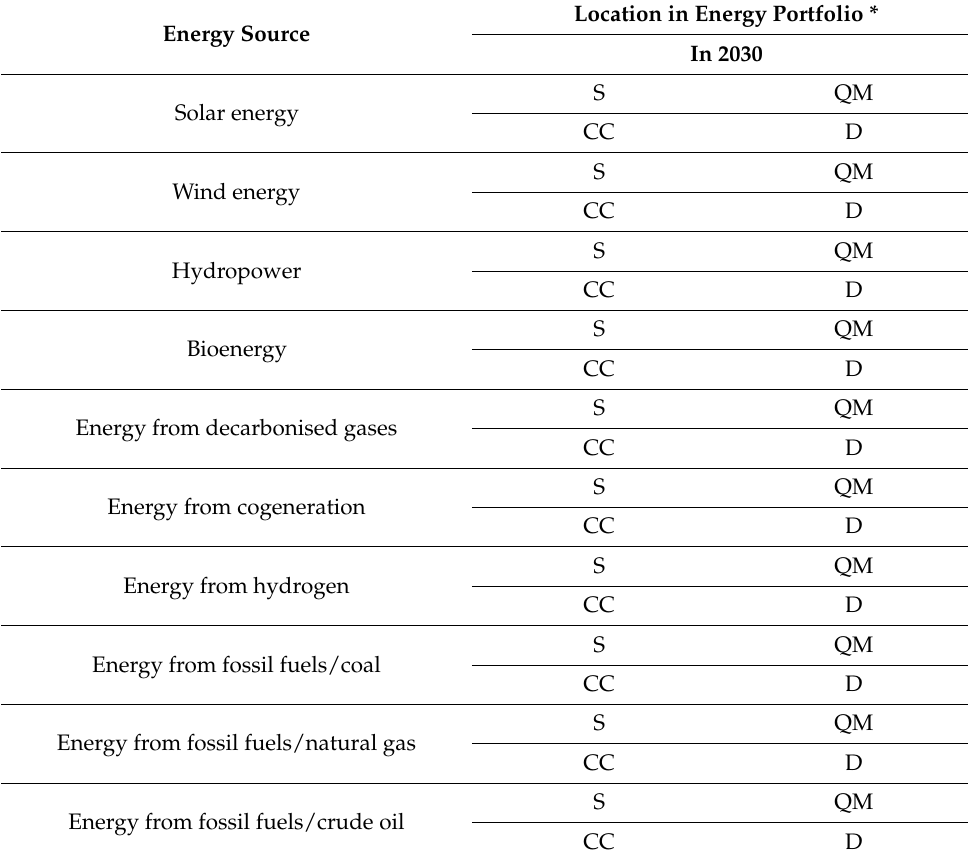
Table 5. Forecast portfolio of energy sources for Eastern Poland macroregion for 2030—results of